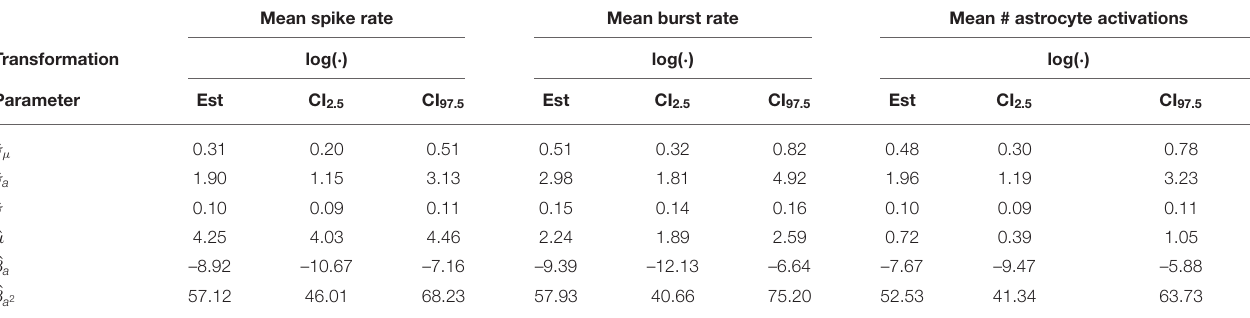
TABLE 4 | Restricted maximum likelihood estimates, lower and upper ends of 95 % confidence intervals for the astrocyte depressing effects experiment. Mean spike rate Mean burst